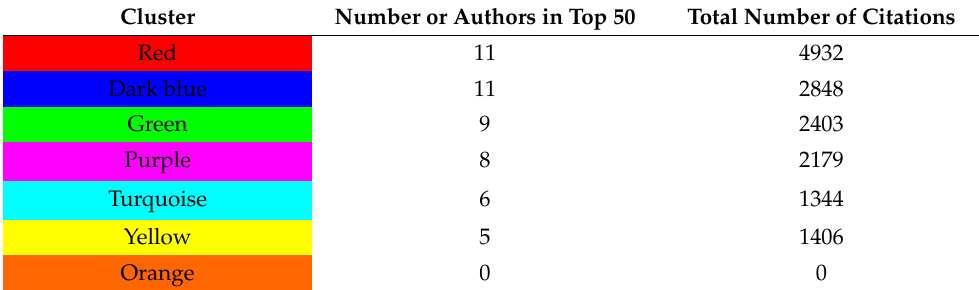
Table 5. Overview of distribution in seven clusters of top 50 authors based on